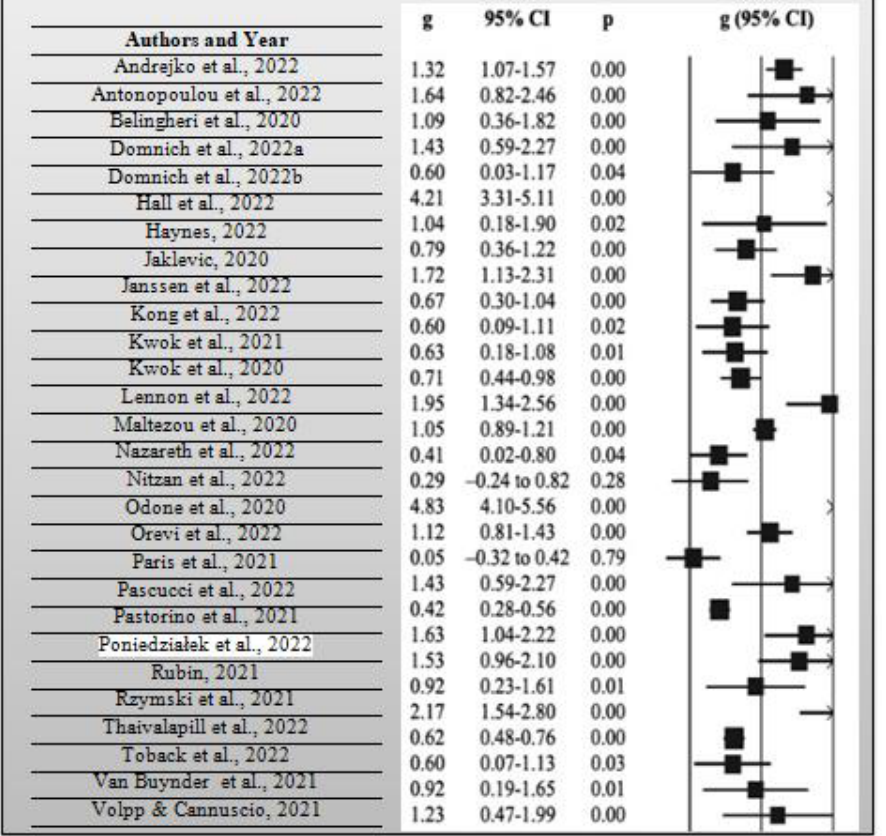
Figure 4. Meta-analysis forest plot for each research study used in this systematic review and meta-analysis